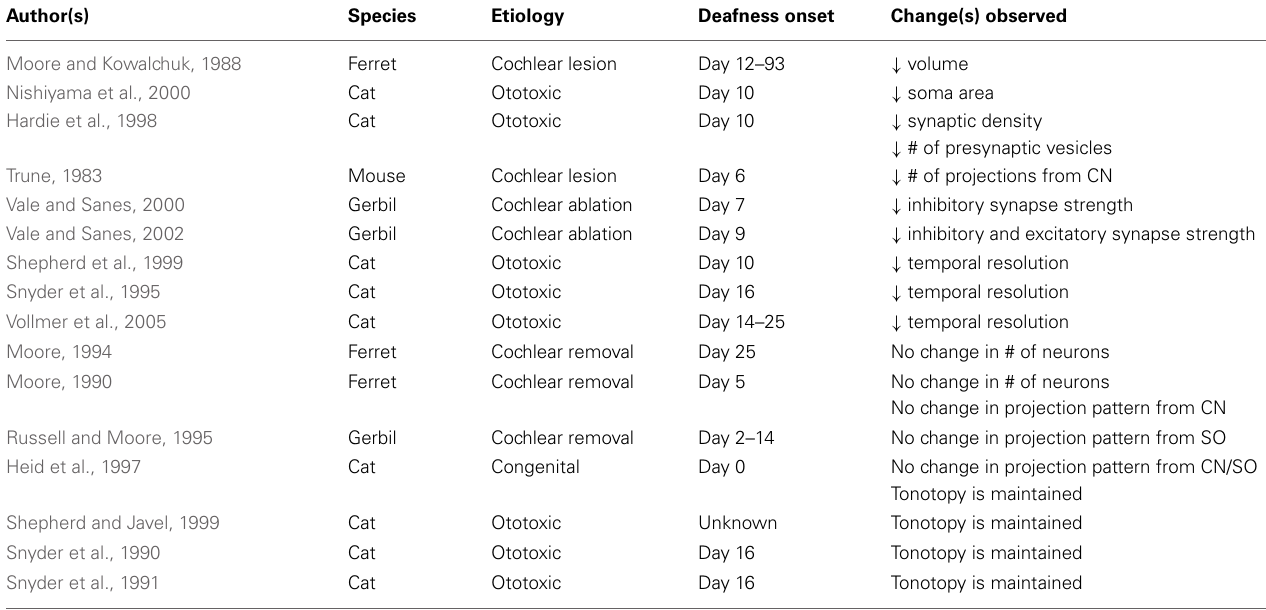
Table 3 | Summary of changes in inferior